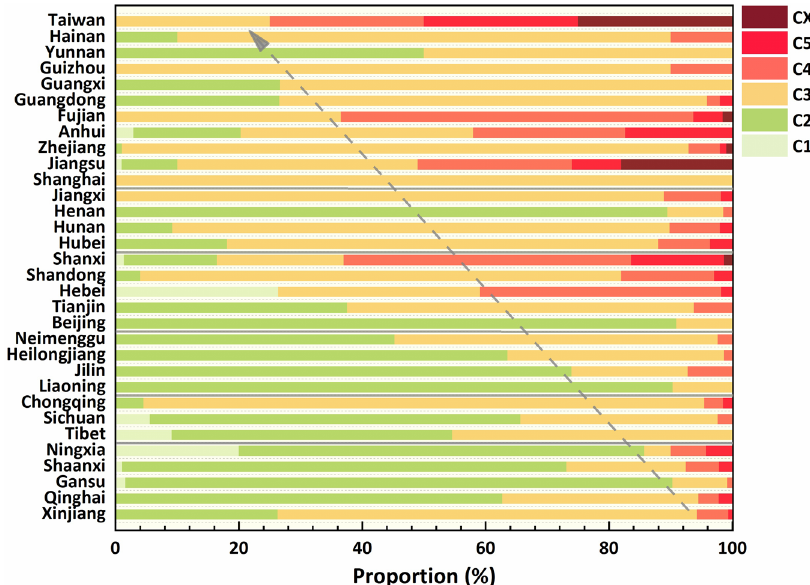
Fig. 3 Results of corrosion categories of galvanized steel in different provinces according to ISO 9223. The corrosivity of the atmospheric environments in different